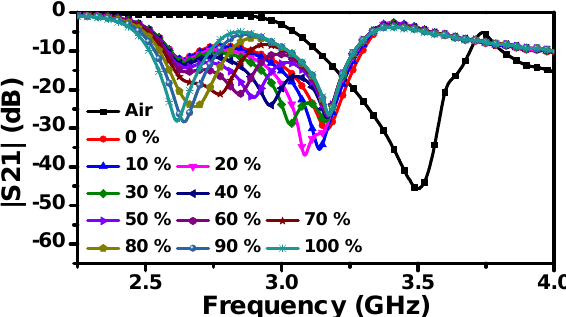
Figure 10. The response of the MIS obtained experimentally when using the chloroform as the reference